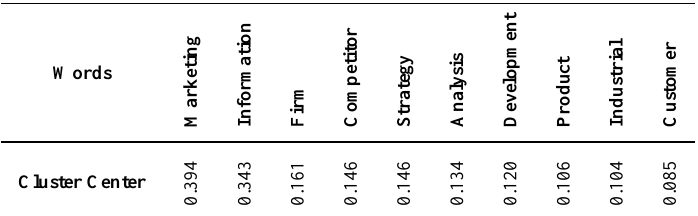
Table 2. Words and final centers of first cluster.